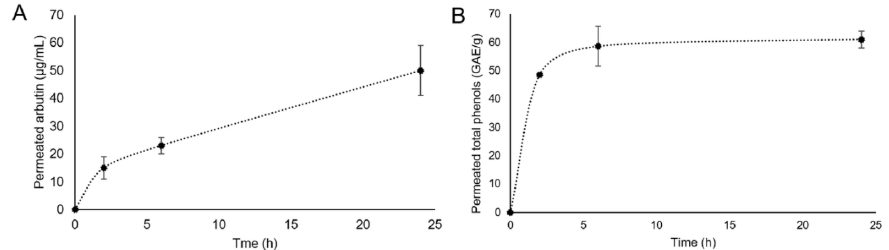
Figure 3. Franz cell permeation kinetics of arbutin ( A ) and total phenols ( B ) detected by HPLC and the Folin–Ciocalteu spectrophotometric method, respectively.